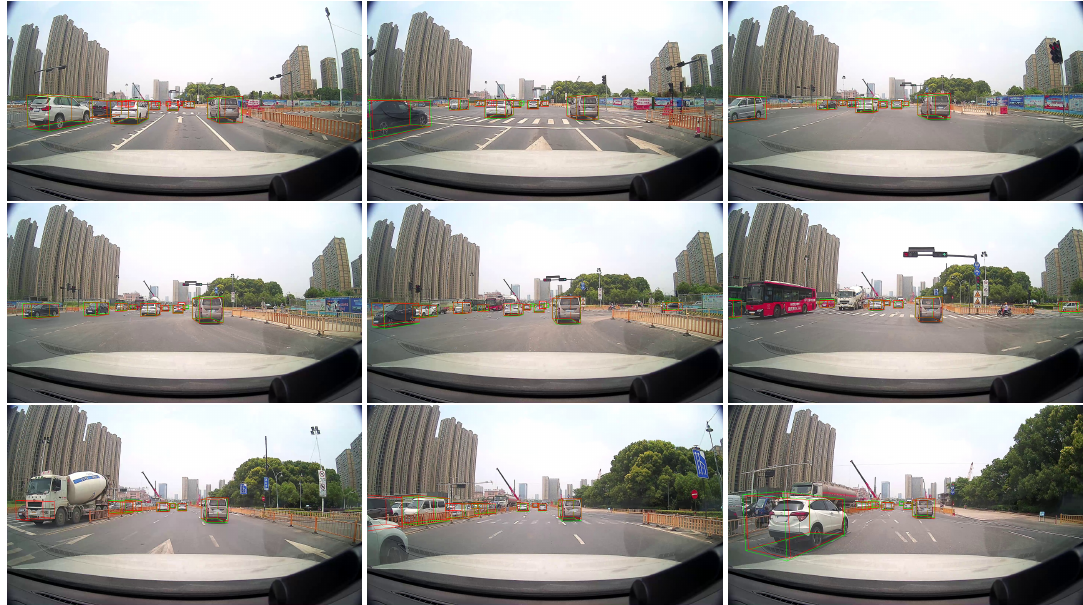
Figure 9. Results of 3D detection in actual scenario. The above are scenes of 9 consecutive frames, and the order is from left to right and then from top to